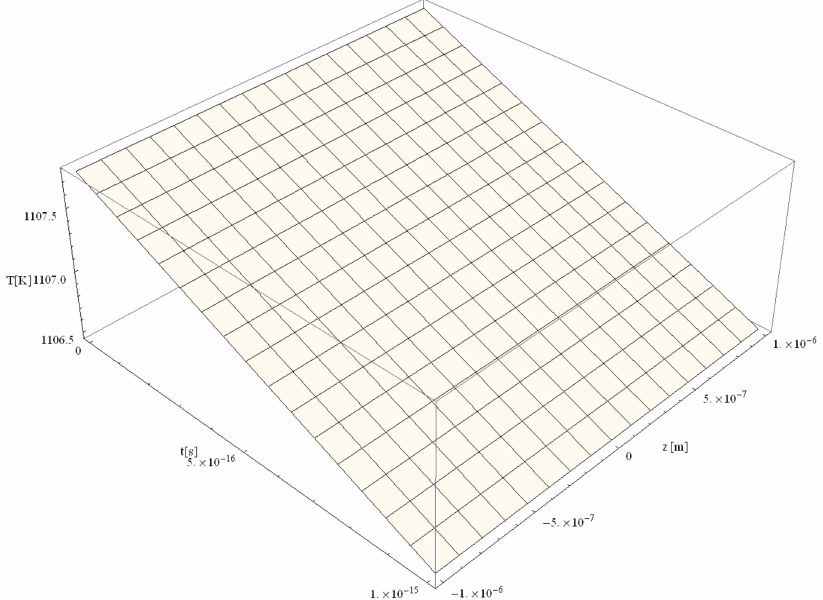
Figure 7. Electron temperature versus time and z during 1 fs simulation after irradiation with a 100 as laser pulse applied to an Au microparticle with a 1000 nm